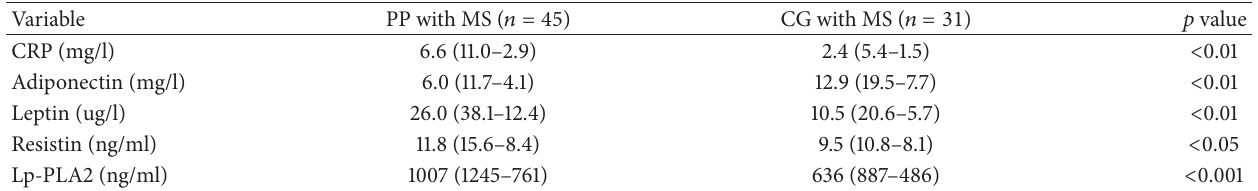
Table 3: Inflammatory markers in the patients (PP) and the controls (CG) with metabolic